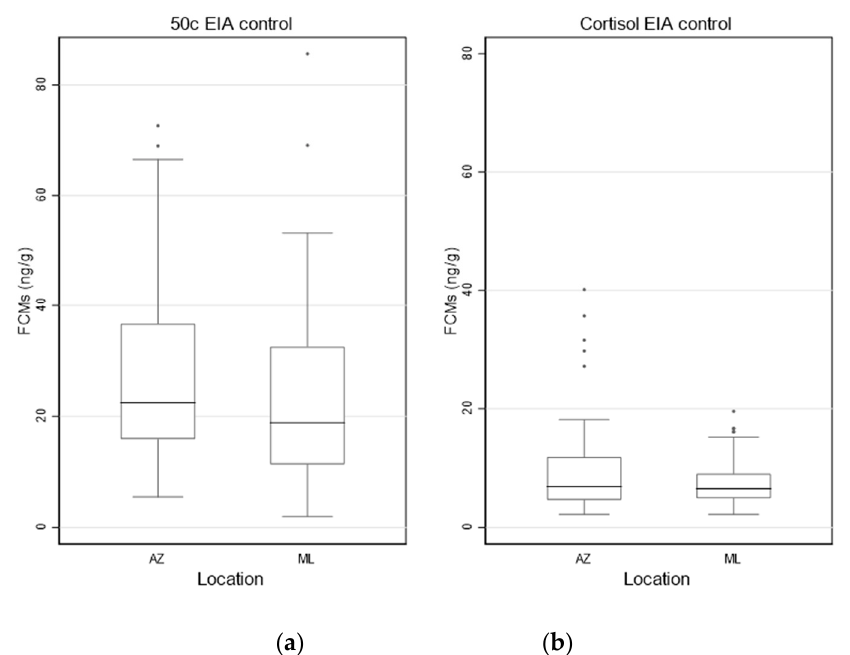
Figure 2. Box and whisker plots showing FCM (faecal cortisol metabolite) values (ng/g) of AZ (N = 36) and ML control koalas (N = 88) measured with the 50c ( a ) and cortisol ( b ) EIAs (enzyme immunoassays) on the first collection day.